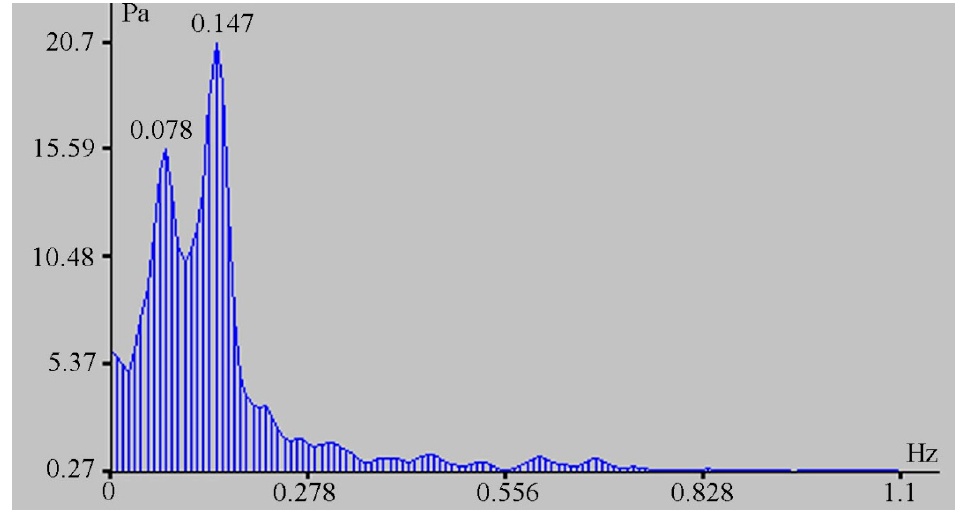
Figure 12. Spectrum of the fragment of the 52.5 m laser strainmeter record. Sensors 2020 , 20 , x FOR PEER REVIEW